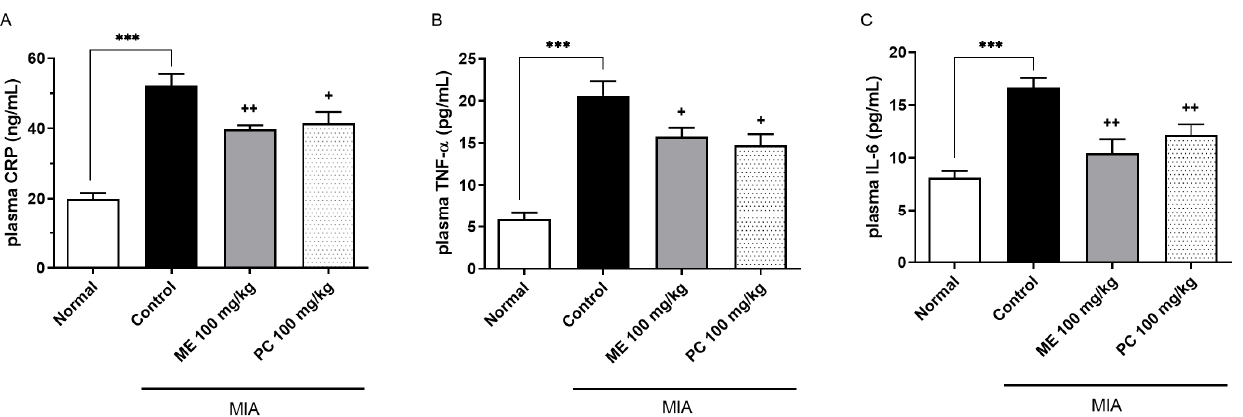
Figure 3. Effect of ME and PC on plasma CRP, TNF- α , and IL-6 levels in the MIA-induced OA model. ME or PC was orally administered to the mice at the dose of 100 mg/kg. The plasma CRP ( A ), TNF- α ( B ), and IL-6 ( C ) levels were measured at 1 h after treatment. The blood was collected from the tail-vein. Error bars represent SEM ( n = 5). (One-way ANOVA for multiple comparisons, plasma CRP: Normal vs. Control p < 0.0001, Control vs. ME 100 mg/kg p = 0.0049, Control vs. PC 100 mg/kg p = 0.0171; plasma TNF- α : Normal vs. Control p < 0.0001, Control vs. ME 100 mg/kg p = 0.0340, Control vs. PC 100 mg/kg p = 0.0114; plasma IL-6: Normal vs. Control p = 0.0002, Control vs. ME 100 mg/kg p = 0.0022, Control vs. PC 100 mg/kg p = 0.0094). ***p < 0.001; + p < 0.05, ++ p < 0.01.